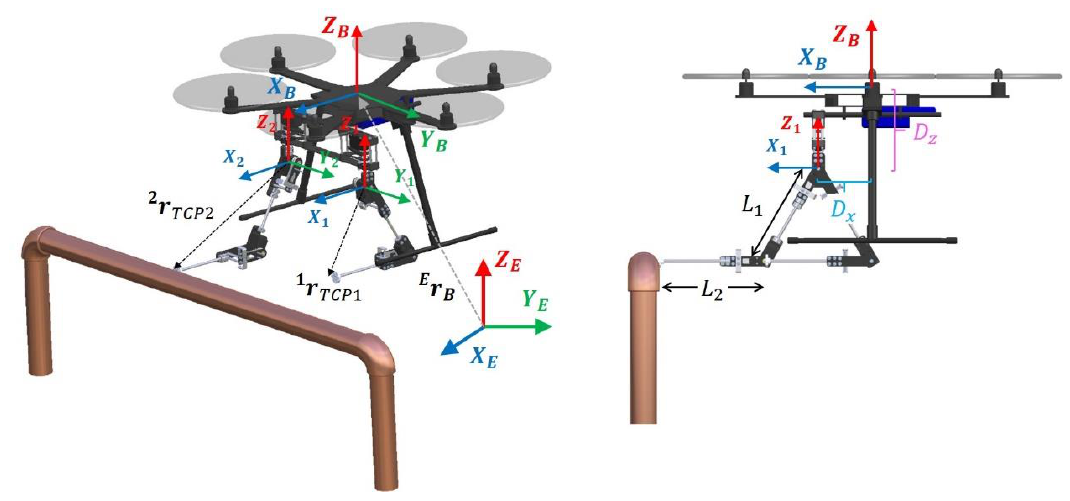
Figure 5. Kinematic model of the dual arm aerial manipulator.